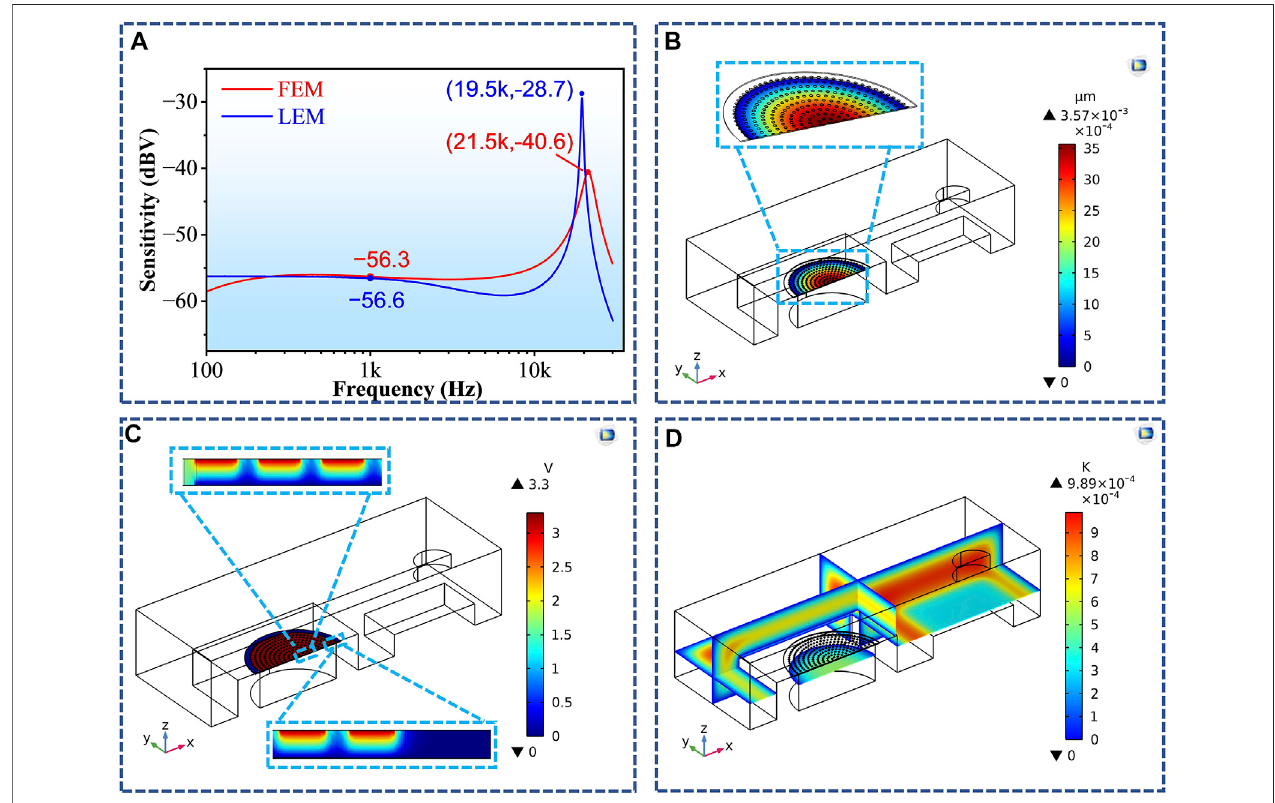
FIGURE4|(A) Comparison of the MEMS microphone frequency response obtained by the FEM and the LEM. (B) Displacement of the membrane at 1 kHz. (C) Electric potential. (D) Temperature oscillation amplitude distribution at 1 kHz.